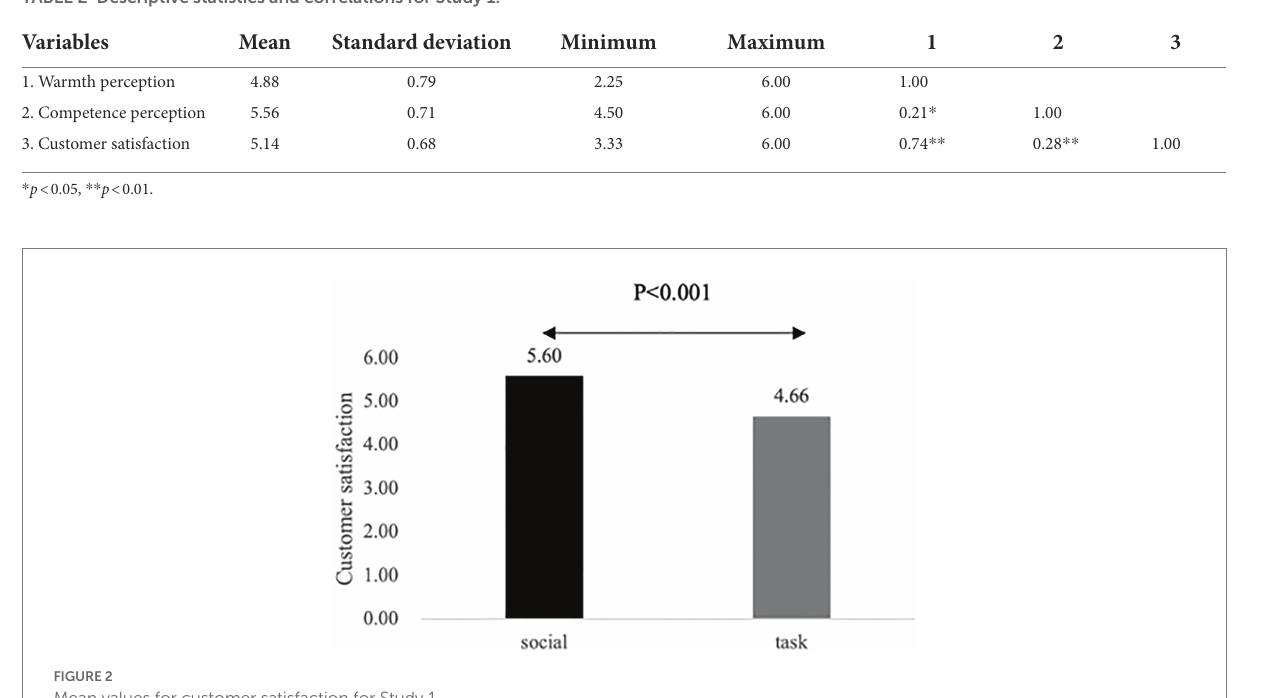
TABLE 2 Descriptive statistics and correlations for Study 1.